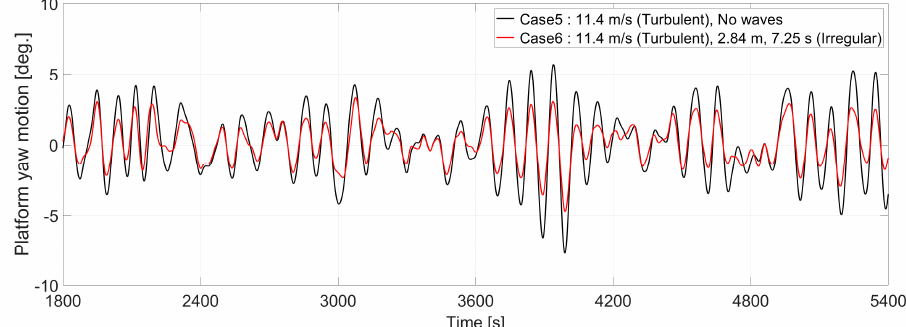
Figure 9. Time series of the platform’s yaw motion for cases 5 and 6.